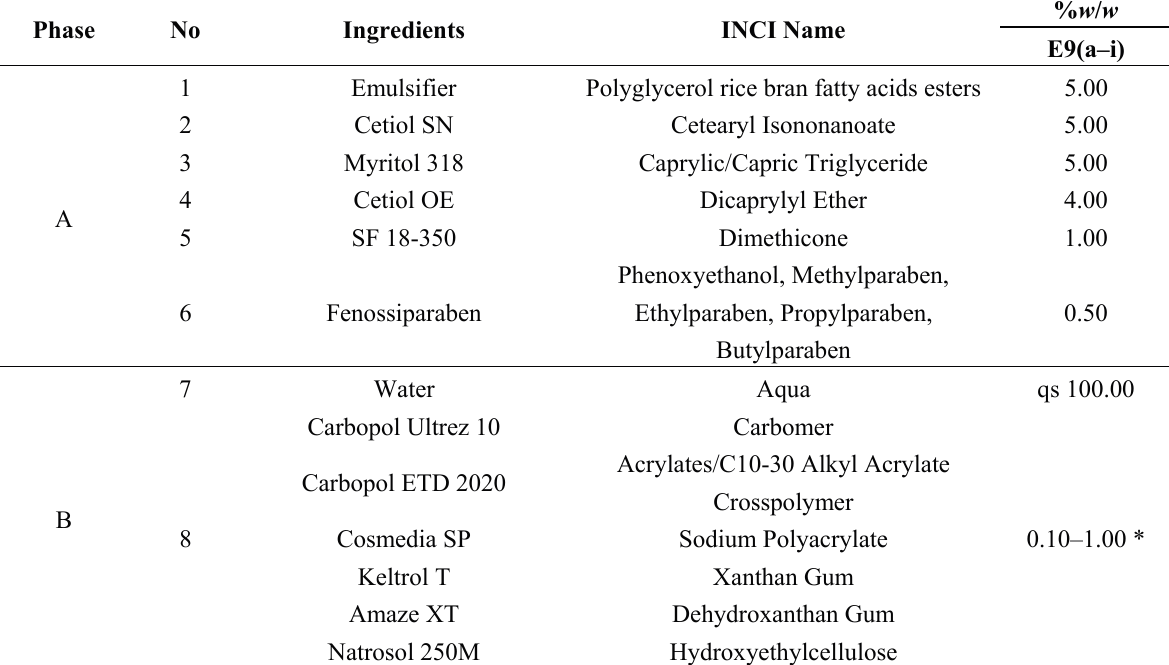
Table 4. Composition of O/W basic emulsions containing different rheological additives.